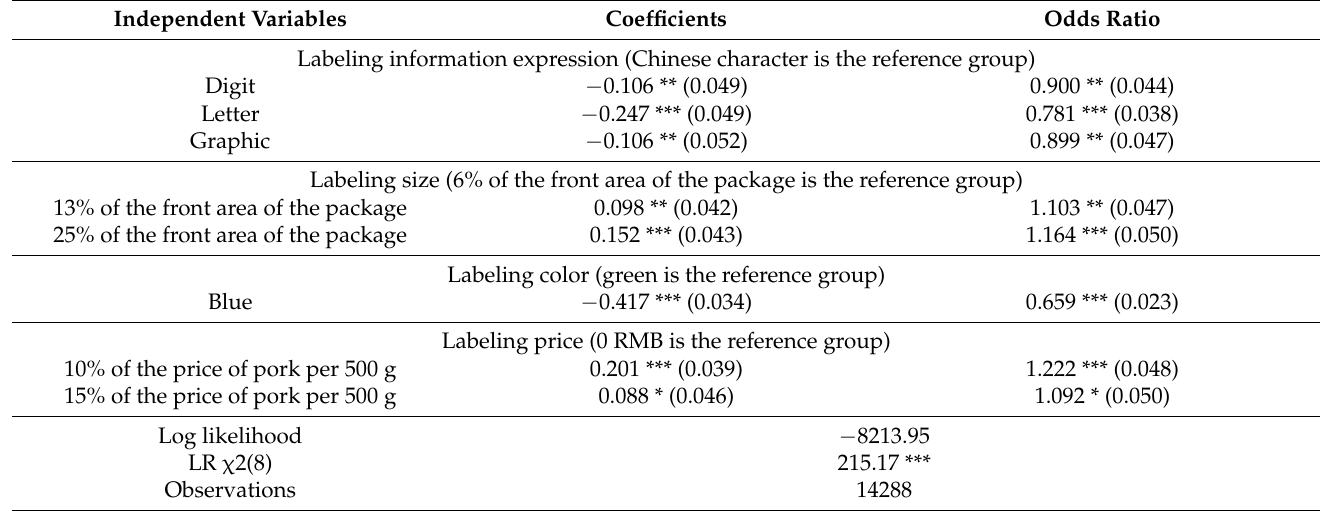
Table 5. Estimation results of conditional logit model for the total